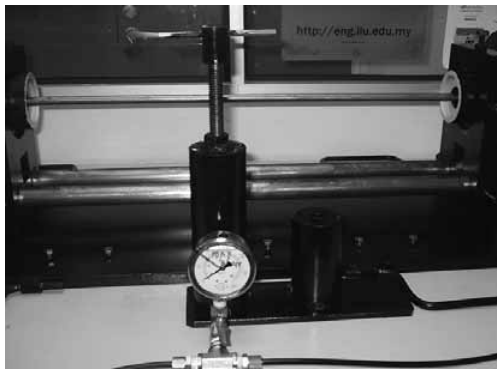
Fig. 5. Oil pressure